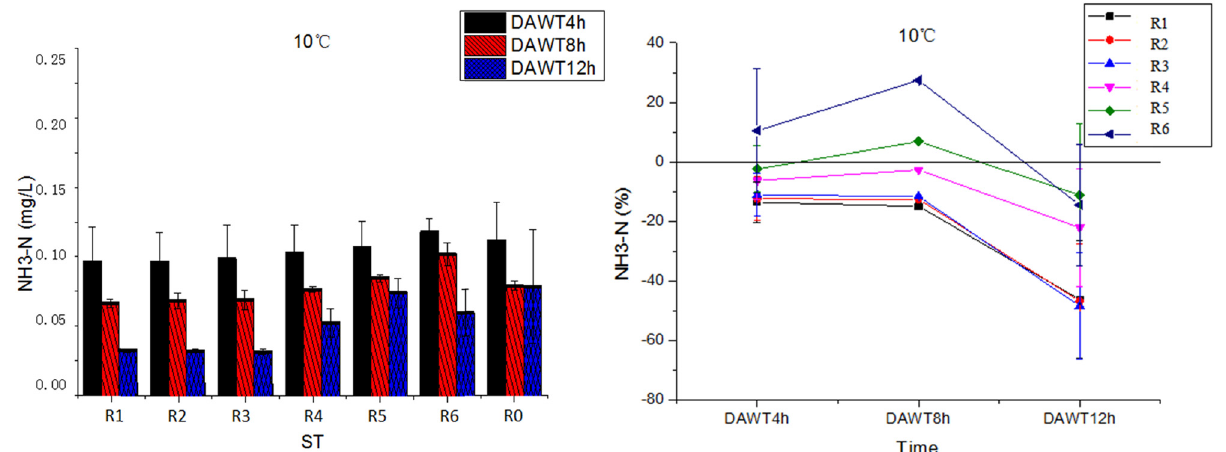
Figure 2: NH 3 – N varies with DWAT.